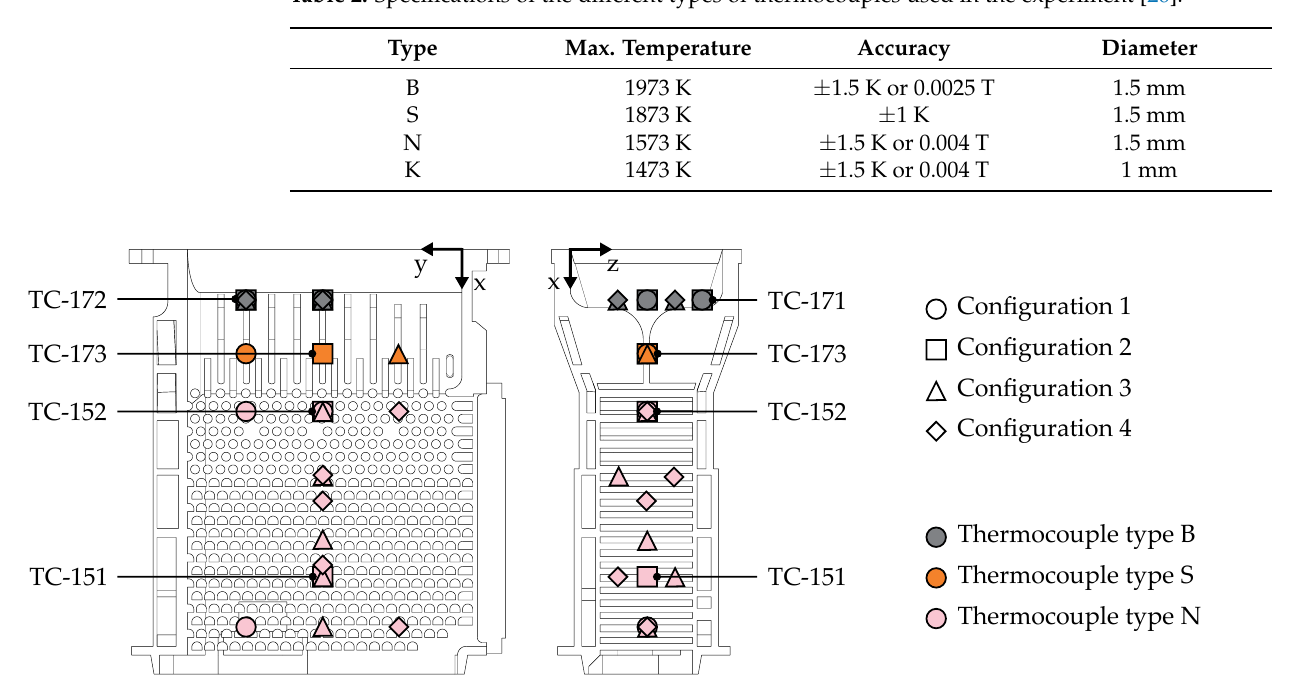
Figure 2. Position and type of the thermocouples in the hot gas heat exchanger in different configura- tions. The thermocouples of configuration 2 are labelled as they are used for the validation of the three-dimensional heat exchanger